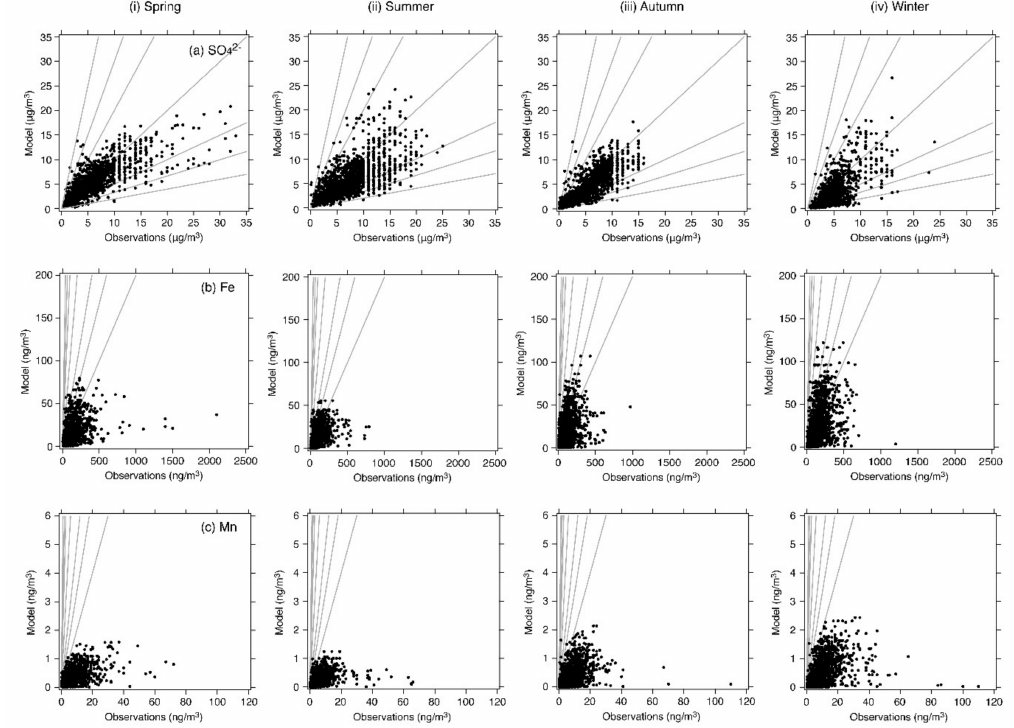
Figure 3. Scatter-plot between observations and the model for daily ( a ) SO 4 2 − , ( b ) Fe, and ( c ) Mn concentrations during ( i ) spring, ( ii ) summer, ( iii ) autumn, and ( iv ) winter. Model results are from the base-case simulation. Note that ( b , c ) are illustrated with different scales of observations and model. Reference lines of 1:1, 1:2, 1:3, and 1:5 are